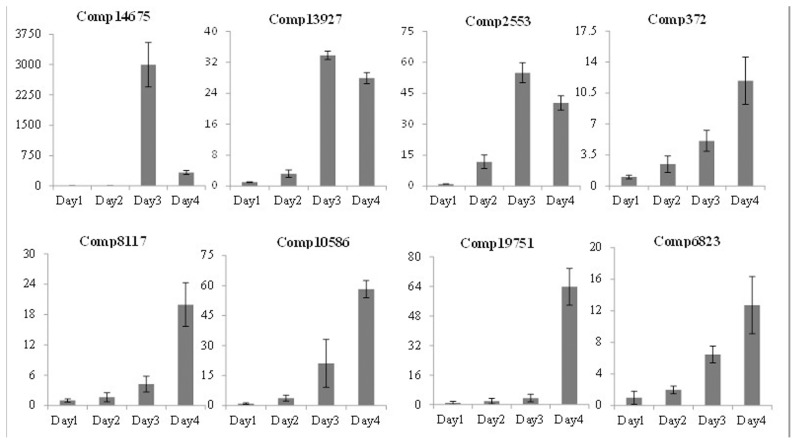
qRT-PCR analysis of 8 additional Citrullus colocynthis genes under drought treatment.The y-axis indicates relative expression compared with Day 1 expression of each gene. The x-axis shows days of water-withholding time points.